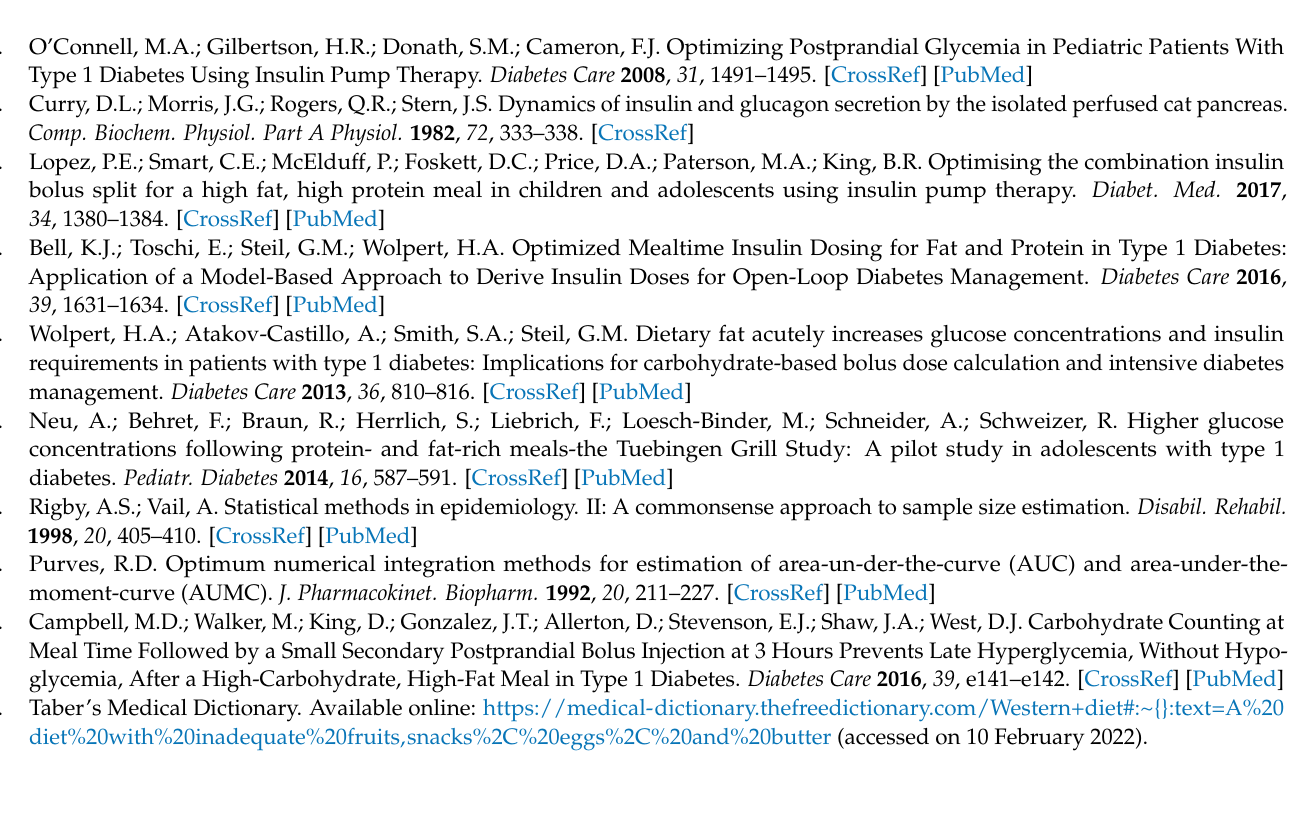
Taber’s Medical Dictionary. Available online: